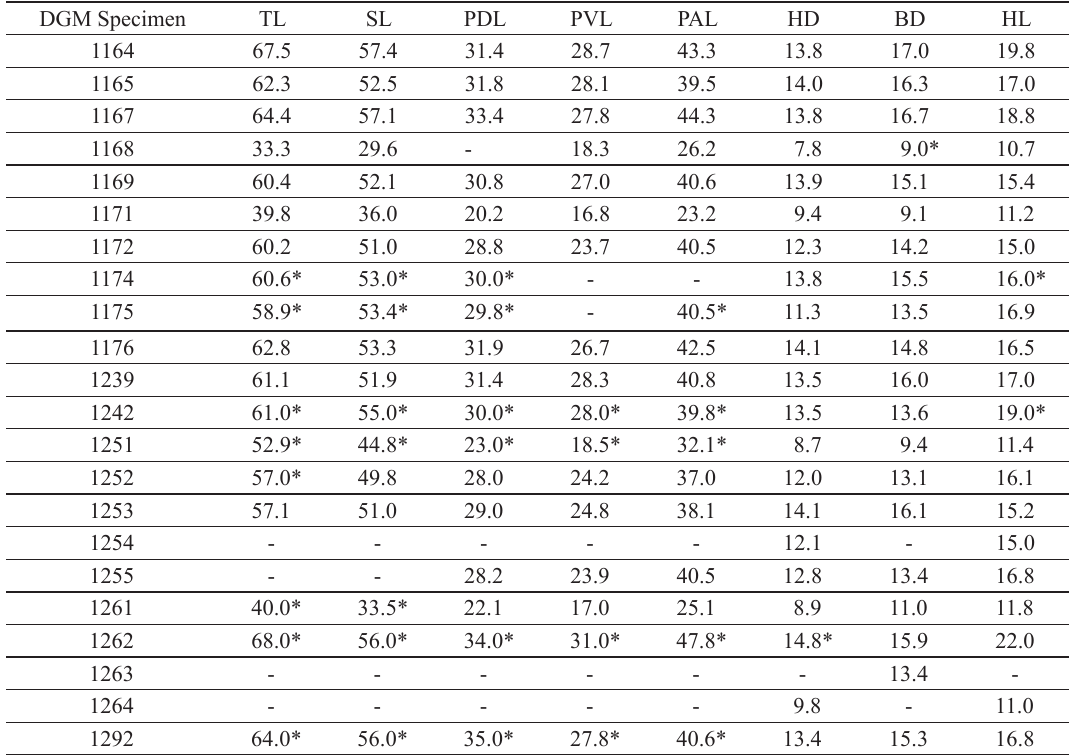
Morphometrical data of selected specimens of † Scutatuspinosus itapagipensis , in millimeters. An asterisk indicates estimated